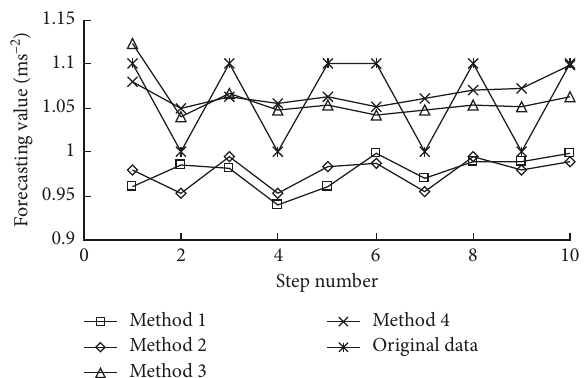
Figure 4: Chaotic prediction results for subseries X